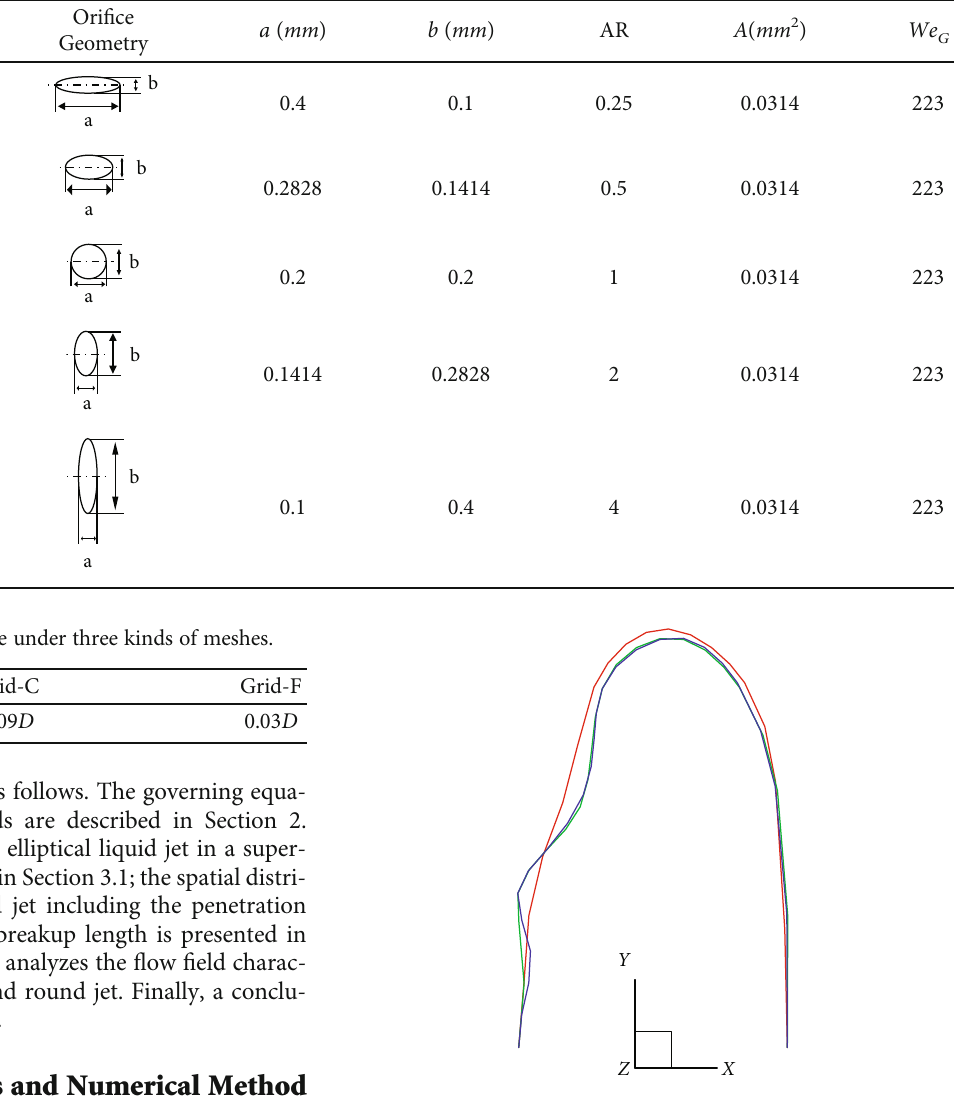
Figure 3: Simulated initial column shapes on Grid-C (red line), Grid-A (green line), and Grid-F (blue line) for Case